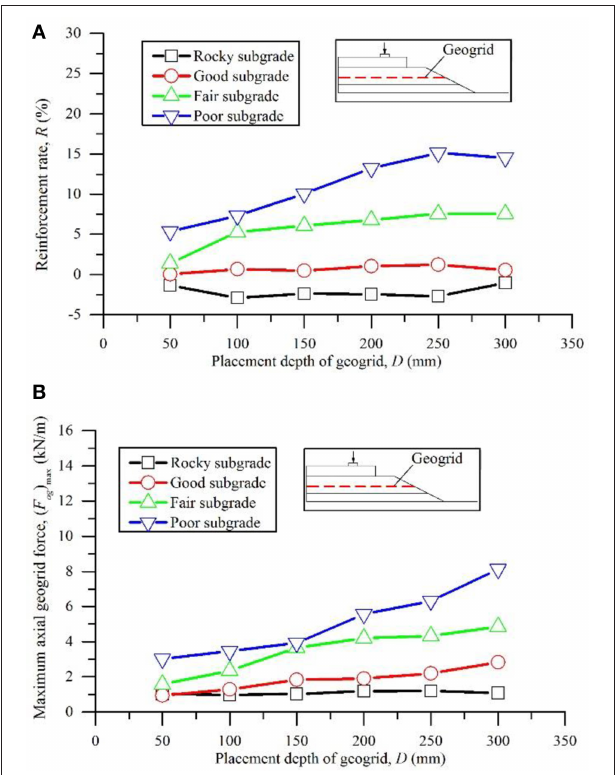
FIGURE 5 | Reinforcement rate and maximum axial force in geogrids with respect to the factor of placement depth of geogrid layer (Case 3): (A) reinforcement rate; (B) maximum axial geogrid force.